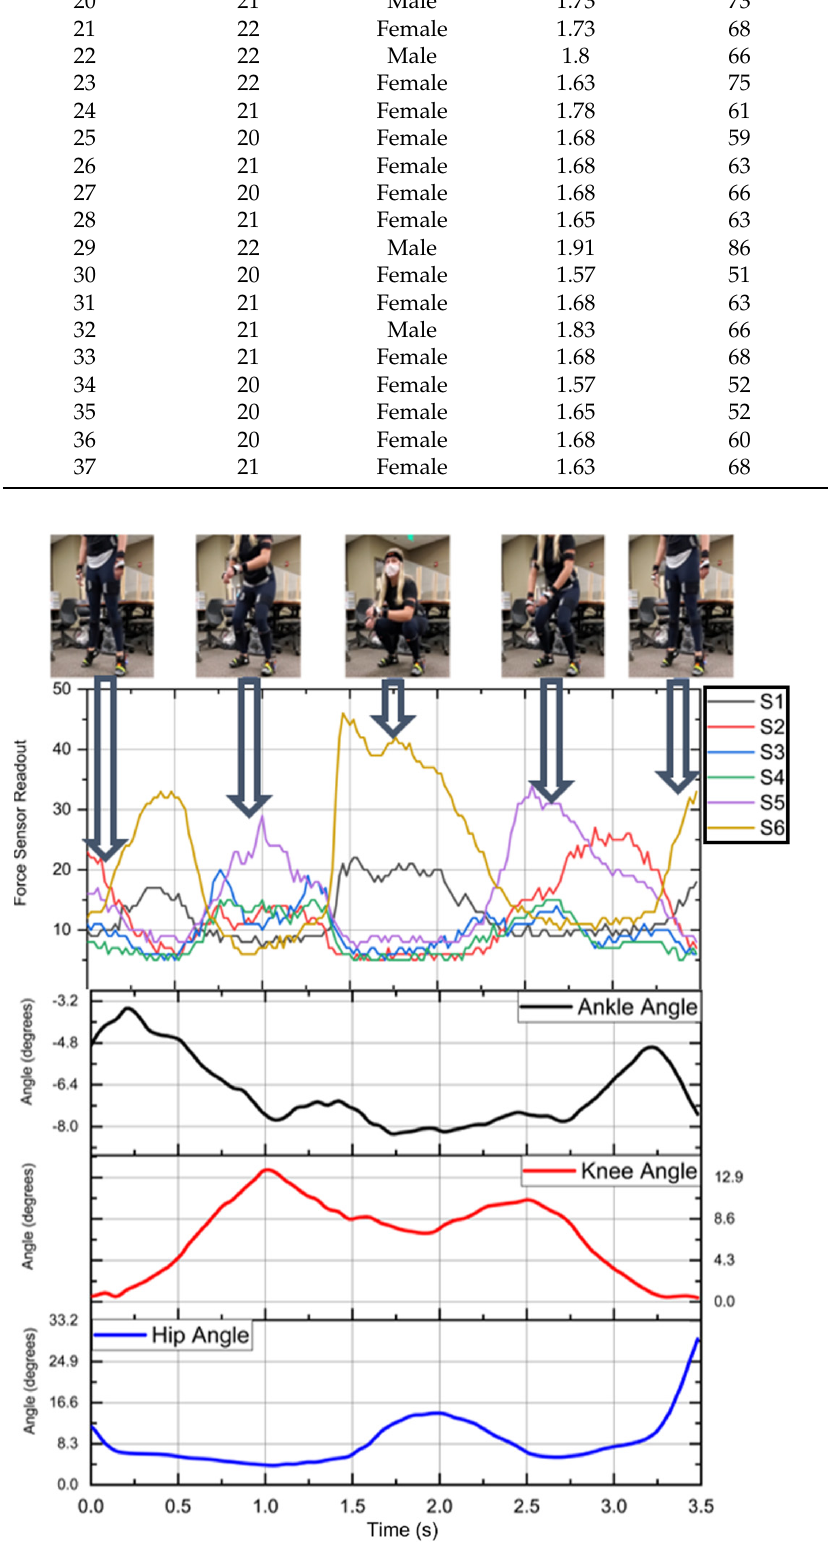
Figure 4. Example of squat motion with accompanying FSR data and Xsens angle outputs.